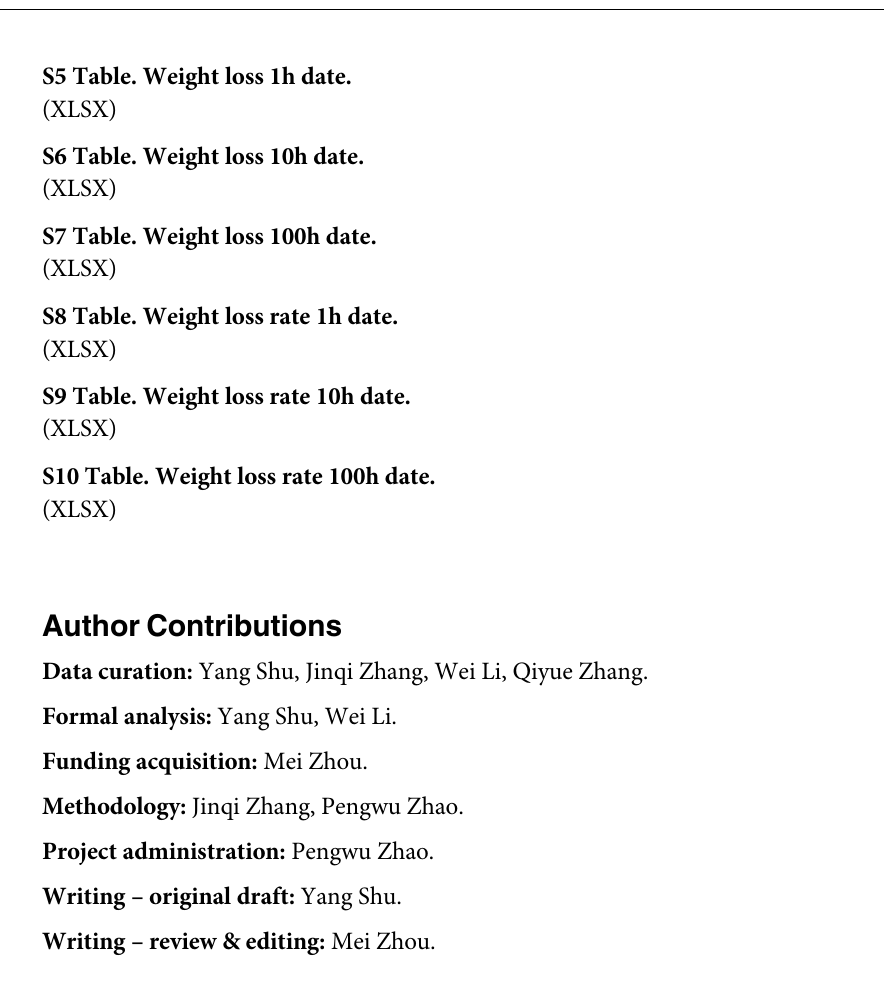
S5 Table. Weight loss 1h date. S6 Table. Weight loss 10h date. S7 Table. Weight loss 100h date. S8 Table. Weight loss rate 1h date. S9 Table. Weight loss rate 10h date. S10 Table. Weight loss rate 100h